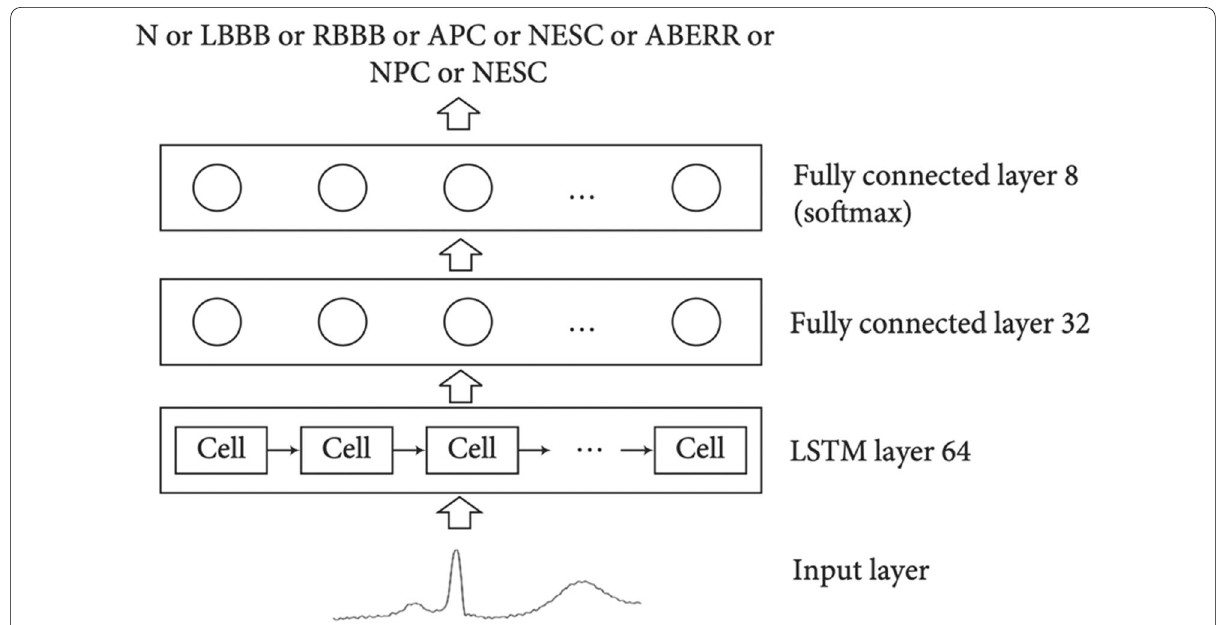
Fig. 3 LSTM recurrent network architecture detecting arrhythmia on imbalanced ECG datasets